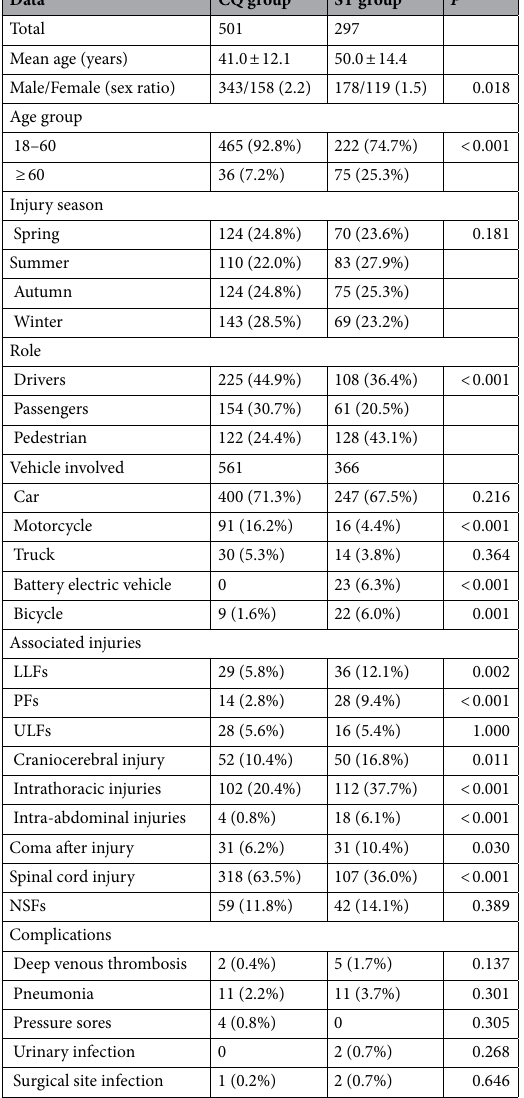
Table 4. Geographic differences in TSFs caused by